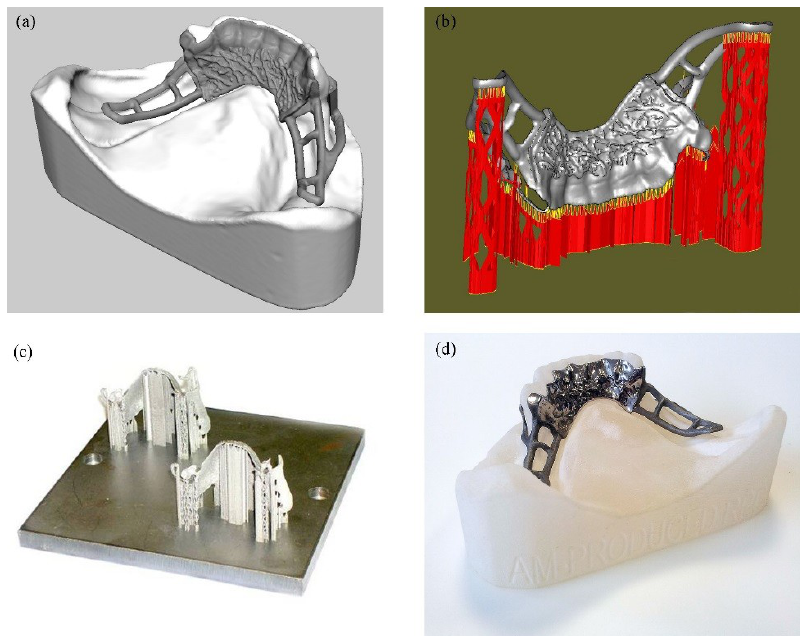
Figure 1. Removable partial denture (RPD) framework; ( a ) virtual design; ( b ) digital model with all relevant features for direct metal laser sintering (DMLS)